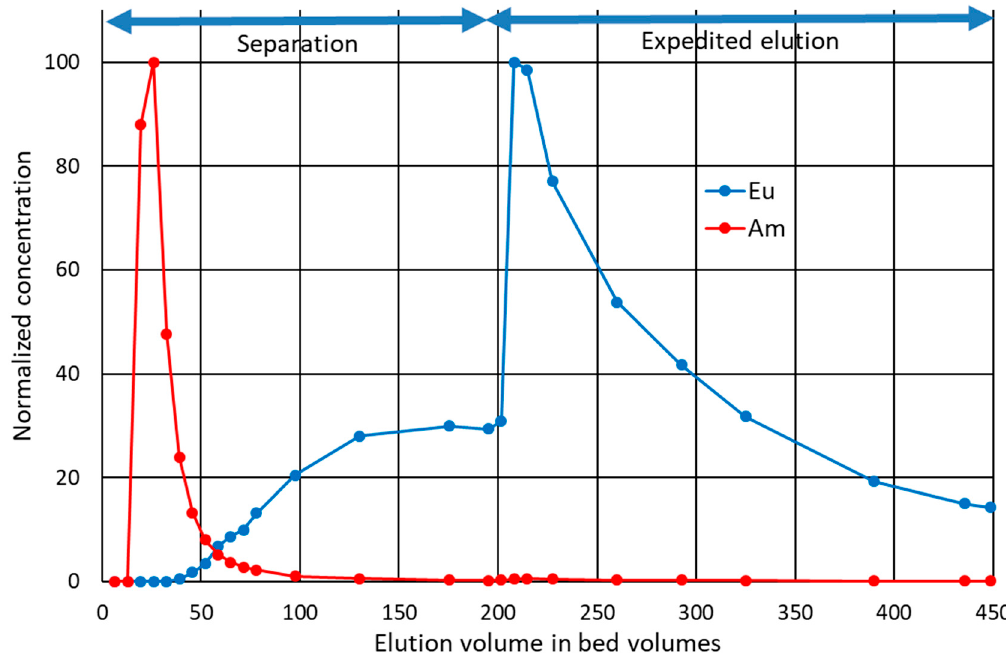
Figure 5. Load-elution column separation of trace Eu(III) and Am(III). The eluate concentration is normalized for each element as a function of the total volume of eluate in bed volumes.